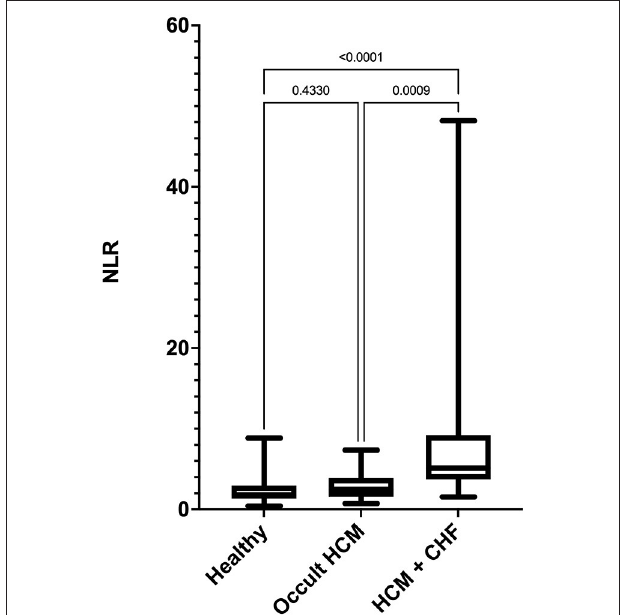
FIGURE 1 | Box-and-whiskers plot of (NLR) in 96 cats. For each plot, the box represents the interquartile range, the horizontal line in each box represents the median, and the whiskers denote the range. The Stage C HCM ( n = 29) group had significantly high NLR than Stage B HCM ( n = 29) and healthy groups ( n = 38). NLR, neutrophil-to-lymphocyte ratio; HCM, hypertrophic cardiomyopathy; CHF, congestive heart